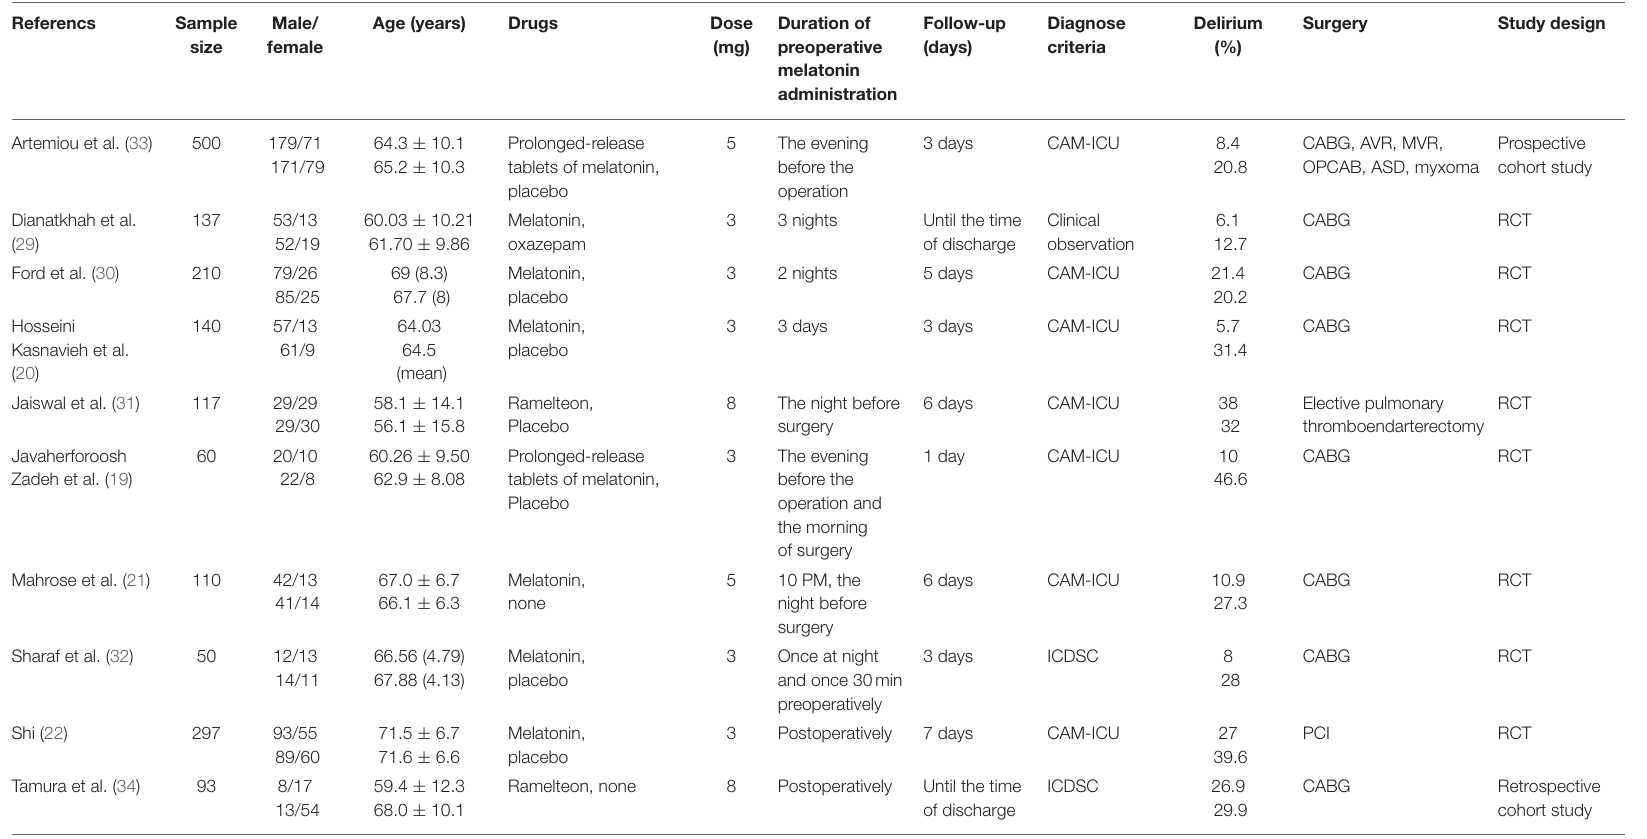
TABLE 1 | Characteristics of studies included in the